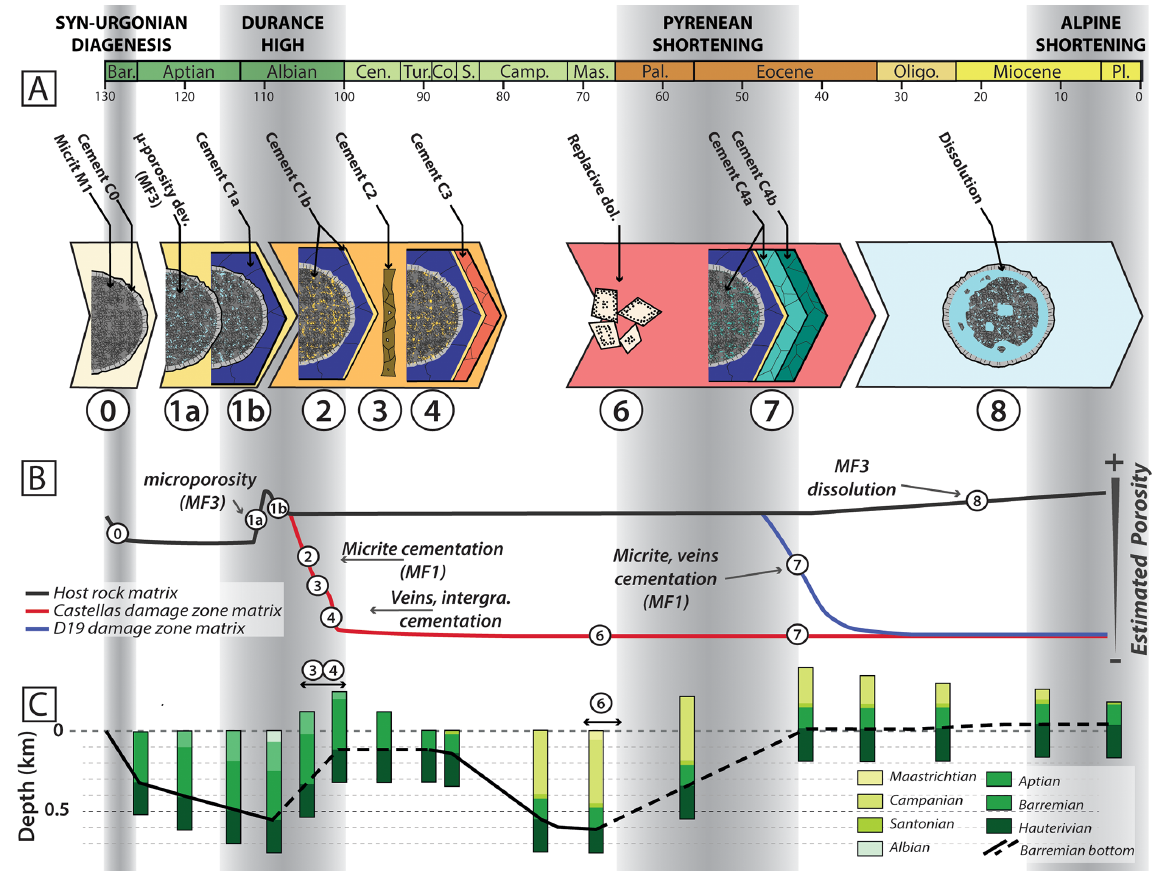
Figure 9. Evolution of reservoir properties. (A) different cementation phases; numbers 0 to 8 correspond to the Steps 0 to 8 (see text for description), (B) relative porosity evolution of the host rock and the two fault zones; (C) burial/uplift curve of Barremian basement (modified from Matonti et al.